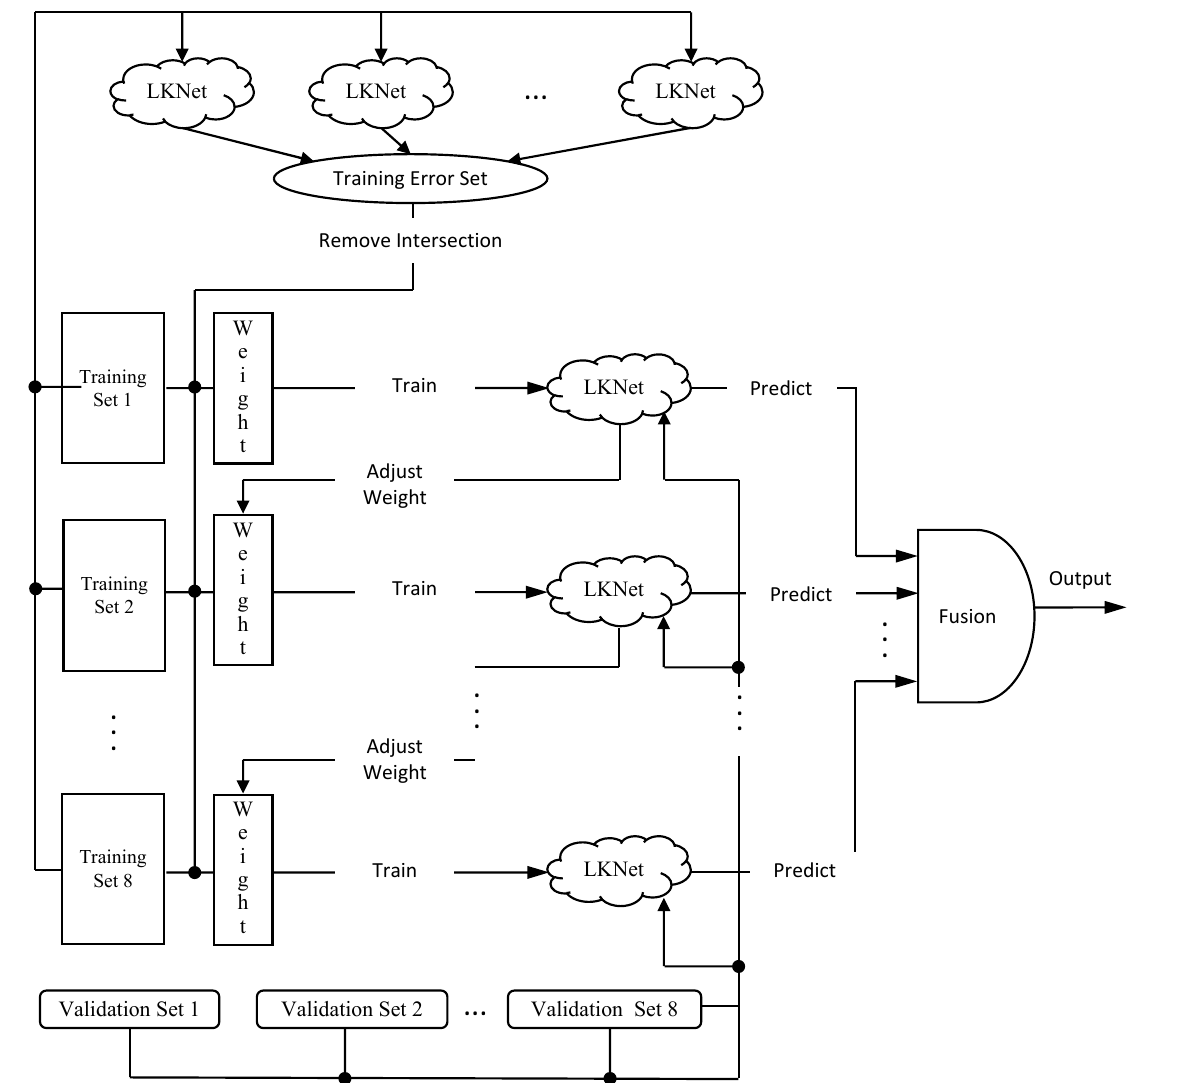
Figure 4. The multifeature sets (MFS)-LKNet Boosting.